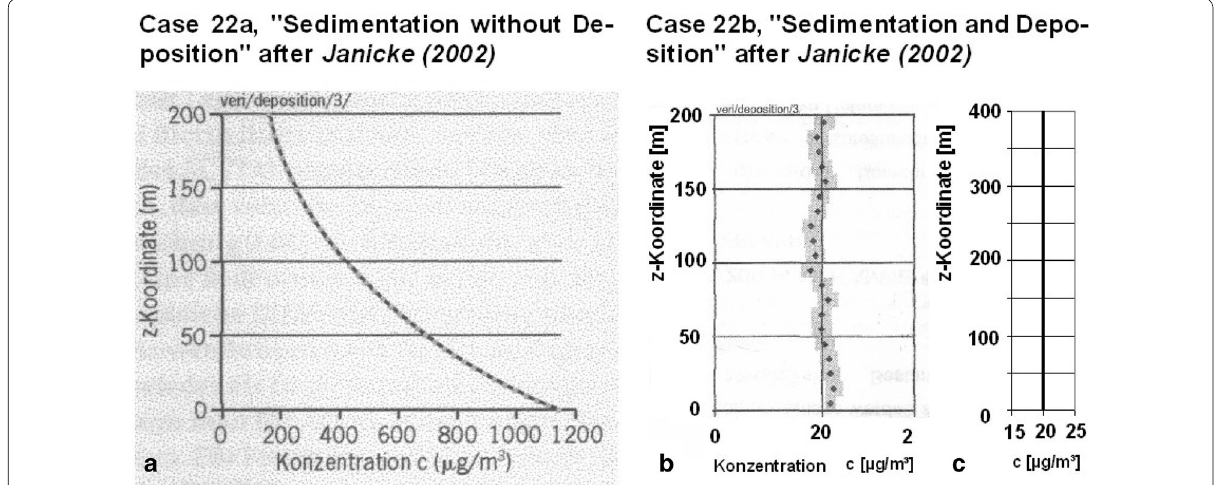
Fig. 1 Concentration distributions for sedimentation with and without deposition; Janicke